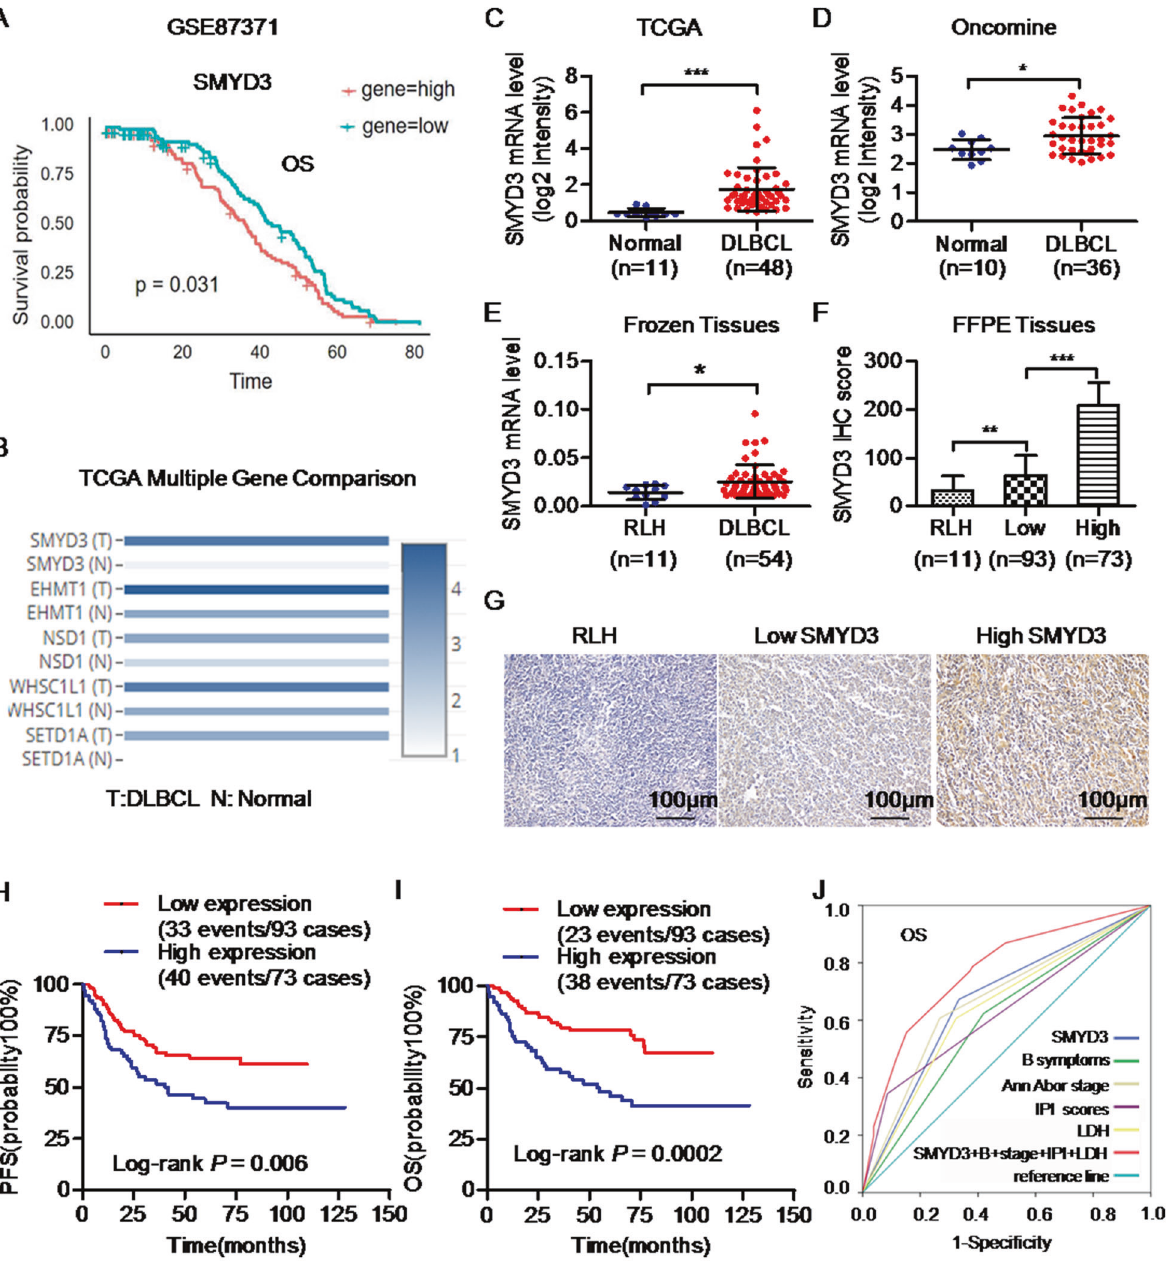
Fig. 1 High levels of SMYD3 are associated with a poor prognosis in patients with DLBCL. A High mRNA levels of SMYD3 were associated with poor OS in patients with DLBCL from the GSE87371 dataset. B The mRNA levels [log 2 (TPM + 1)] of SMYD3, EHMT1, NSD1, WHSC1L1 (NSD3) and SETD1A were signi fi cantly higher in DLBCL than those of normal tissue samples in TCGA database. Analysis of ( C ) TCGA and D Oncomine databases suggested that the mRNA levels of SMYD3 in DLBCLs were signi fi cantly higher than those of normal tissue samples. The E mRNA and F protein expression levels of SMYD3 in DLBCL clinical samples were signi fi cantly higher than those in RLH samples. G Immunohistochemical staining images of SMYD3 in RLH samples (H-score, 40) and in DLBCLs with low (H-score, 100) or high (H-score, 260) SMYD3 protein levels. Magni fi cation, x200. Scale bar, 100 μ m. Patients of DLBCLs with high SMYD3 protein expression had a shorter PFS ( H ) and a shorter OS ( I ) than those with low SMYD3 protein expression respectively. P -values from log-rank tests are shown. J ROC curves of OS showing the AUROC of SMYD3 expression combined with Ann Arbor stage, B symptoms, IPI score and serum LDH level vs. AUROCs of each factor alone. DLBCL, diffuse large B-cell lymphoma; SMYD3; SET and MYND domain containing 3; EHMT1, euchromatic histone lysine methyltransferase 1; NSD1/3, nuclear receptor binding SET domain protein 1/3; WHSC1L1, Wolf-Hirschhorn syndrome candidate 1-like 1; SETD1A, SET domain containing 1A histone lysine methyltransferase. ROC Receiver operating characteristic, AUROC Area under the ROC curve, PFS Progression-free survival, OS, Overall survival, TPM Transcripts per million, RLH Reactive lymphoid hyperplasia.